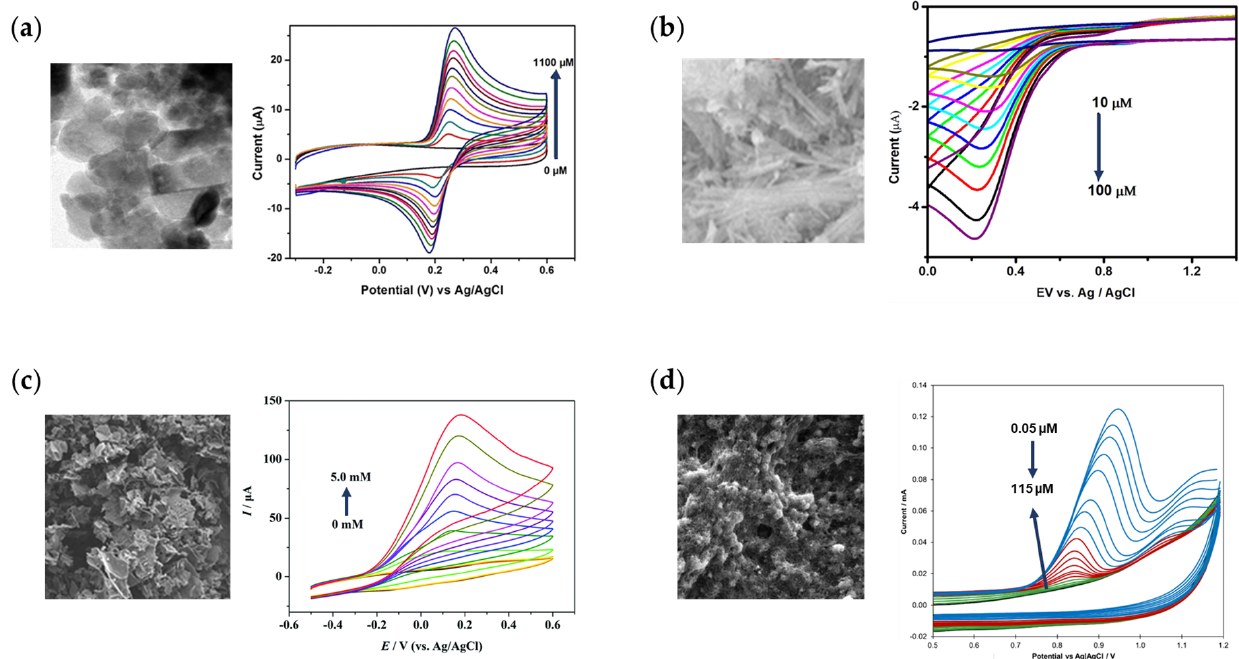
Figure 11. ( a ) Voltammetry determination of caffeic acid in red wines using nitrogen-doped carbon material [111]. ( b ) Graphene carbon nitride-doped silver molybdate immobilized Nafion for sensitivity of Cr ions [112]. ( c ) Ultra sensitivity toward hydrazine based on palladium − loaded laser − scribed graphite carbon nanosheets [113]. ( d ) Carbon/metal–organic framework composite for citalopram detection [114].